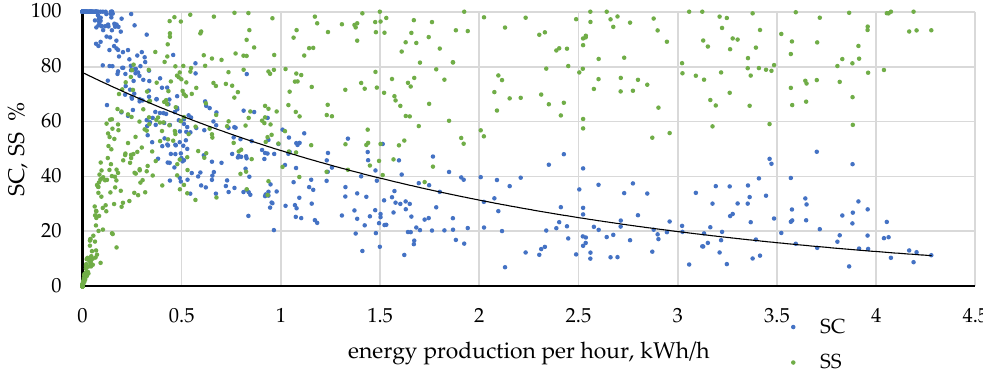
Figure 10. Self-consumption coefficient (SC) and self-sufficiency coefficient (SS) as a function of energy production per hour.